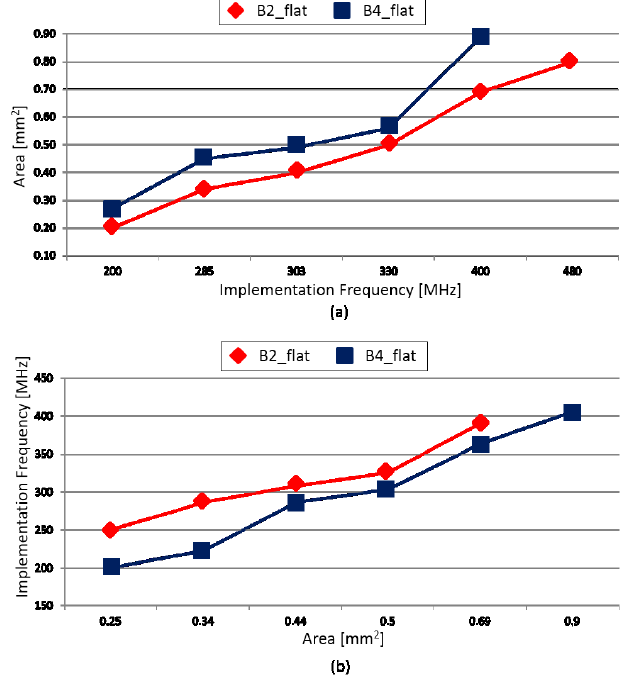
Figure 8. 1024 × 1024 I/Os Flat MSSN radix-2 (B2) versus radix-4 (B4): iso-frequency ( a ) and iso-area ( b ) post-synthesis